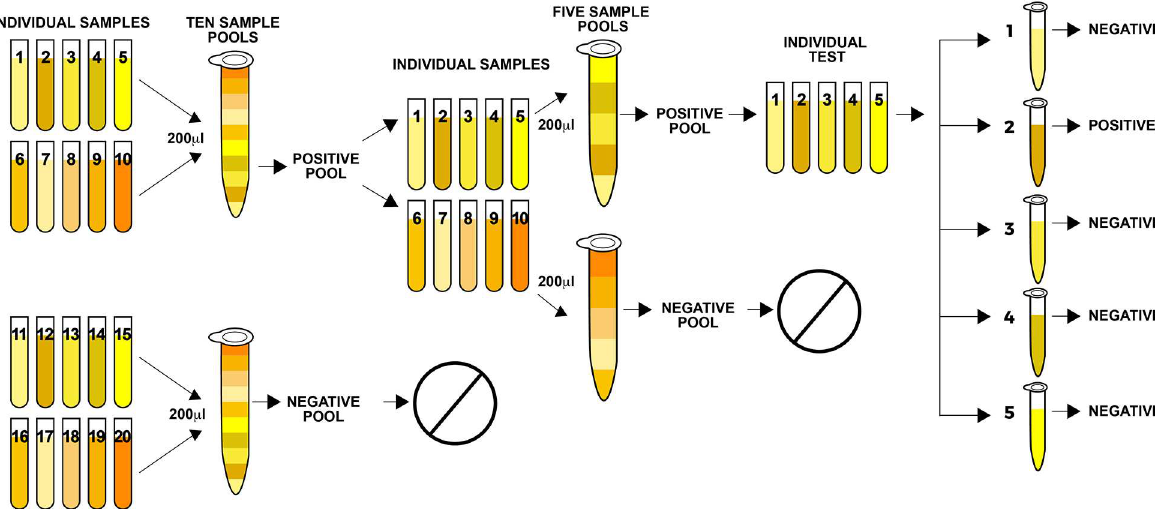
Fig 1. Diagram of pooling method for serum samples from blood donors. The diagram shows the constructionof sample pools and analysisfor HPgV viremia in healthyblood donors. Positive samples from the pool were re-tested in smaller pools each time until we detected the positive individualdonor